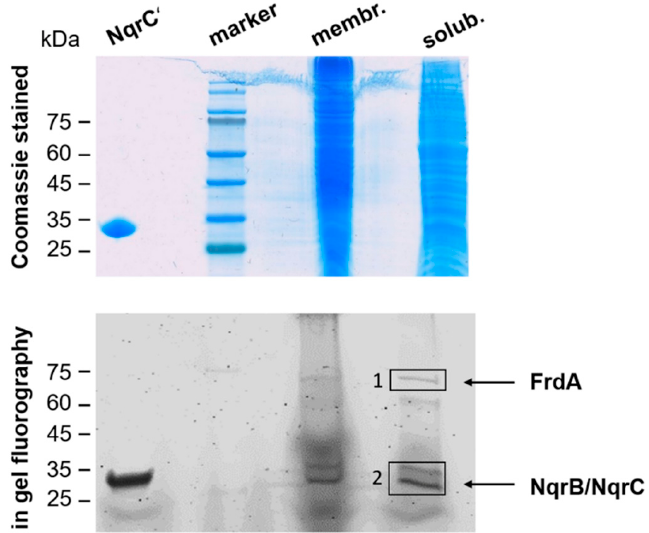
Figure 6. Detection of flavinylated subunits from QFR and NQR in P. bivia membranes. Membranes (100 µg; membr.) and membranes solubilized with DDM (100 µg; solub.) of P. bivia were separated by SDS PAGE. Proteins were stained with Coomassie (upper panel) and analyzed by in-gel fluorography (lower panel) to detect flavinylated proteins. NqrC’ (25 kDa), the FMN-containing domain of subunit NqrC from V. cholerae NQR, served as the control (2 µg). Black boxes (1 and 2) indicate bands subjected to tryptic digestion and mass spectrometry analysis.